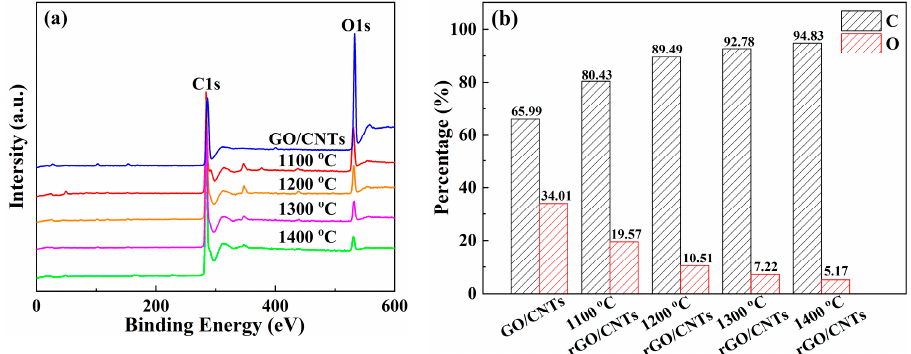
Figure 4. ( a ) XPS spectra of the rGO / CNT composite films; ( b ) the percentage of carbon and oxygen in the composite films with di ff erent annealing temperatures.